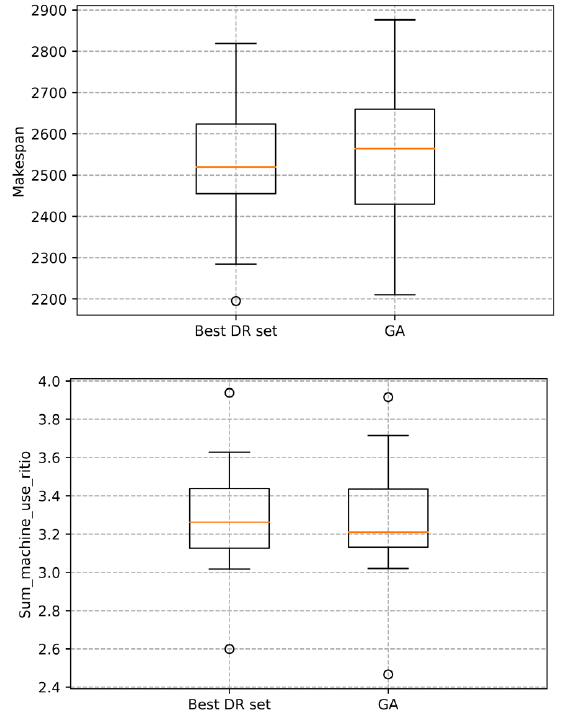
Figure 11. Low job heterogeneity and a low manufacturing system load rate.